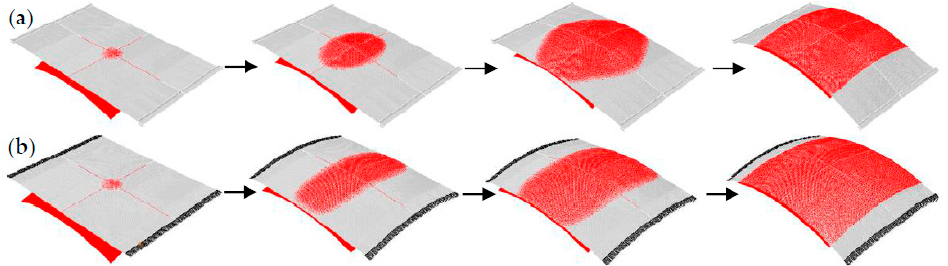
Figure 6. Contact region evolution for spherical parts. ( a ) C-SF with sheet metal of l t = 100 mm; ( b ) UC-SF with sheet metal of l t = 50 mm.